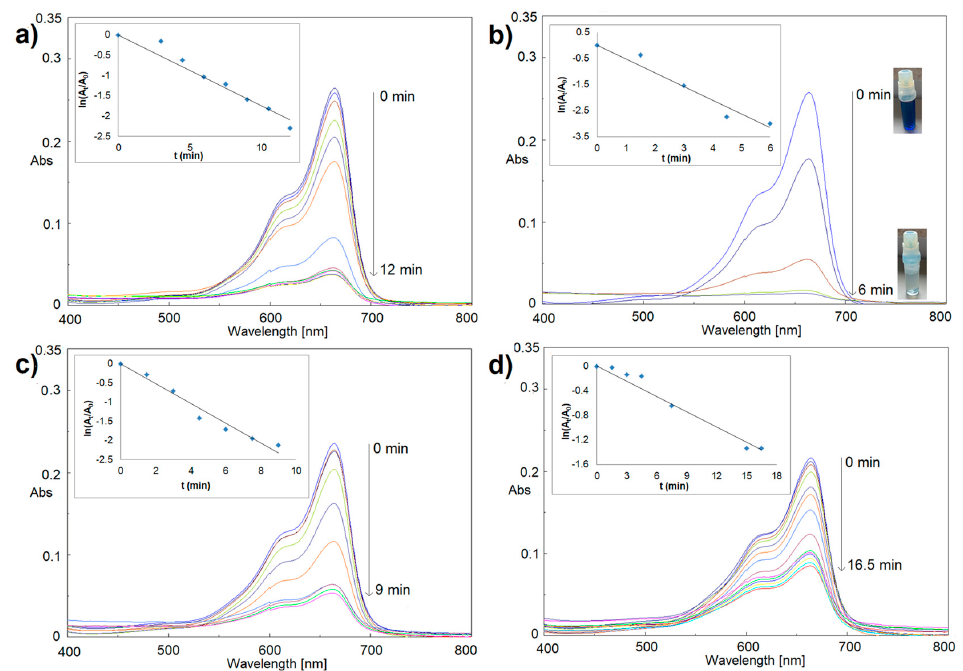
Figure 6. Catalytic reduction of MB by NaBH 4 in the presence of Ir-NP1 ( a ), Ir-NP2 ( b ), Ir-NP3 ( c ), and Ir-NP4 ( d ). Table 3. The specific rate constant of catalytic reduction of MB by NaBH 4 for reference, in the pres- ence of extracts (GM1, GM2, GM3, and GM4), and the presence of iridium nanoparticles (Ir-NP1, Ir- NP2, Ir-NP3, and Ir-NP4). Experiments were conducted in triplicate.